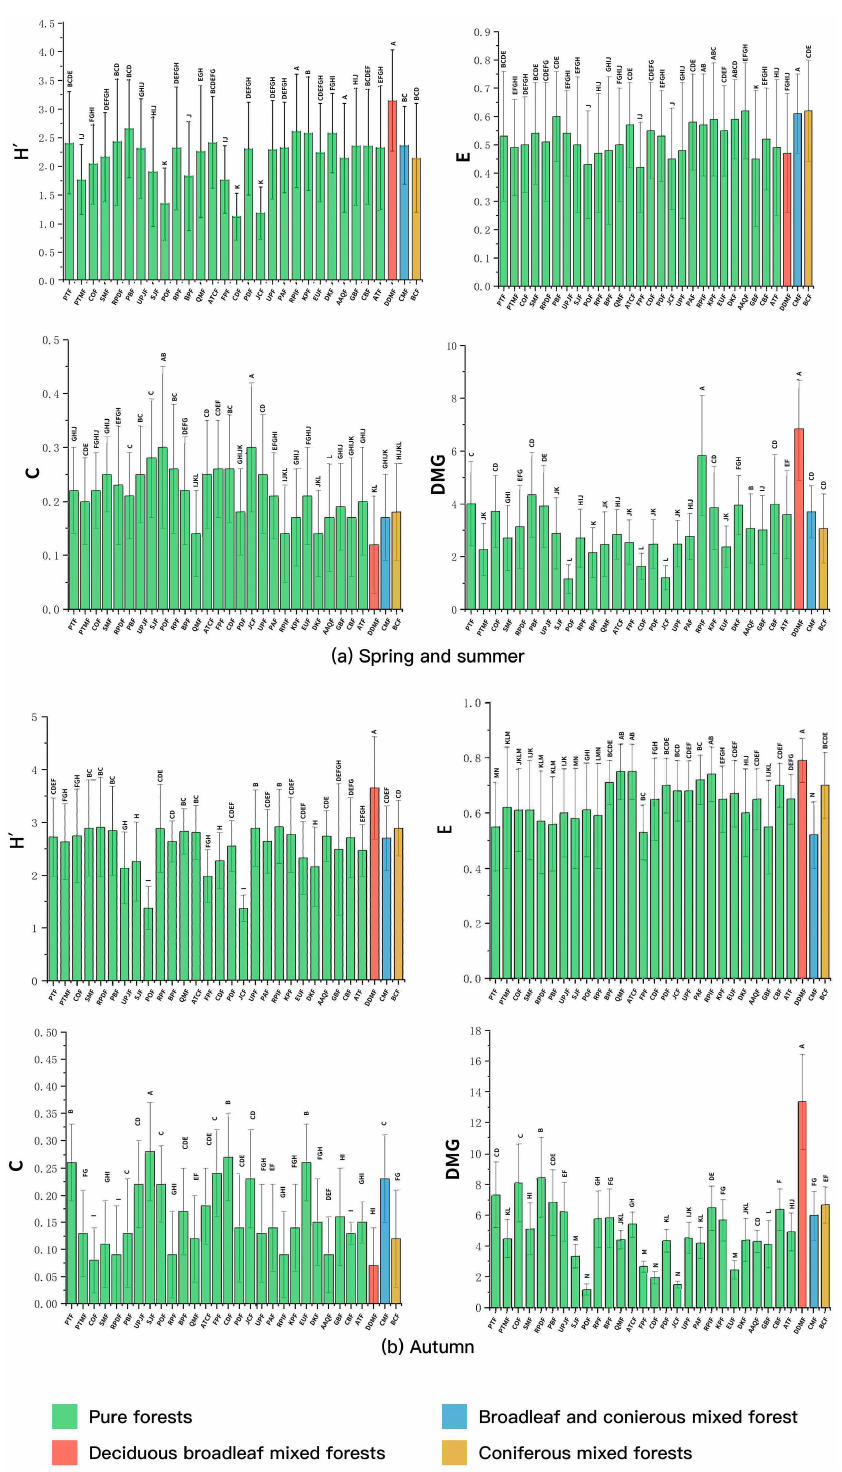
Figure 6. Plant diversity characteristics of different community types in Beijing urban forests (( a ) spring and summer; ( b ) autumn). H (cid:48) : Shannon–Weiner index; C: Simpson index; E: Pielou index; DMG: Margalef richness index. Note: Different lowercase letters indicate significant differ- ences in the diversity values of different community types ( p < 0.05). Abbreviations of community names refer to Table